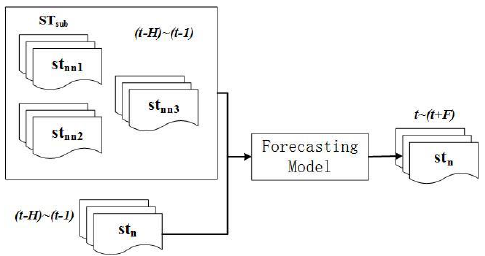
Figure 2. Data flow of spatiotemporal